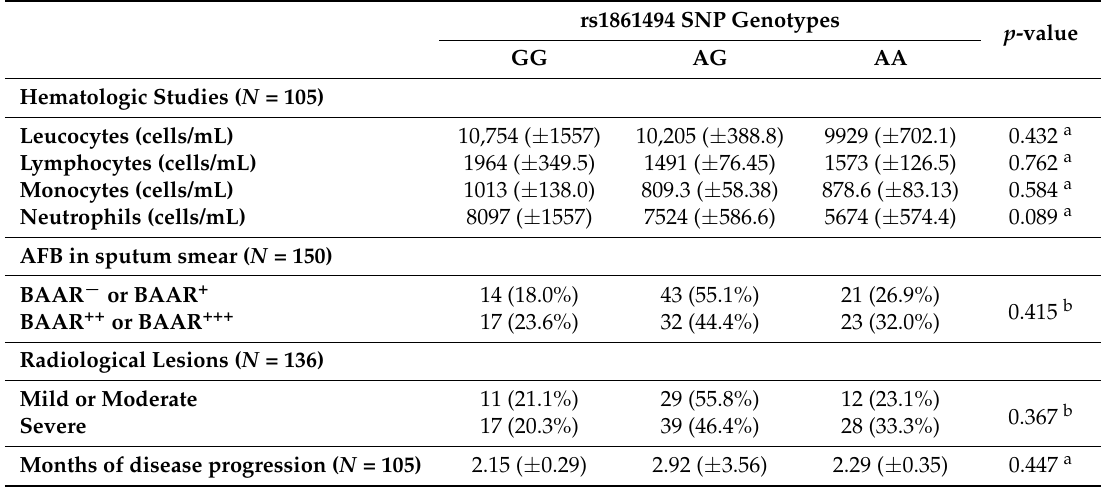
Table 4. Association between the IFNG rs1861494 SNP genotypic variants and some clinical